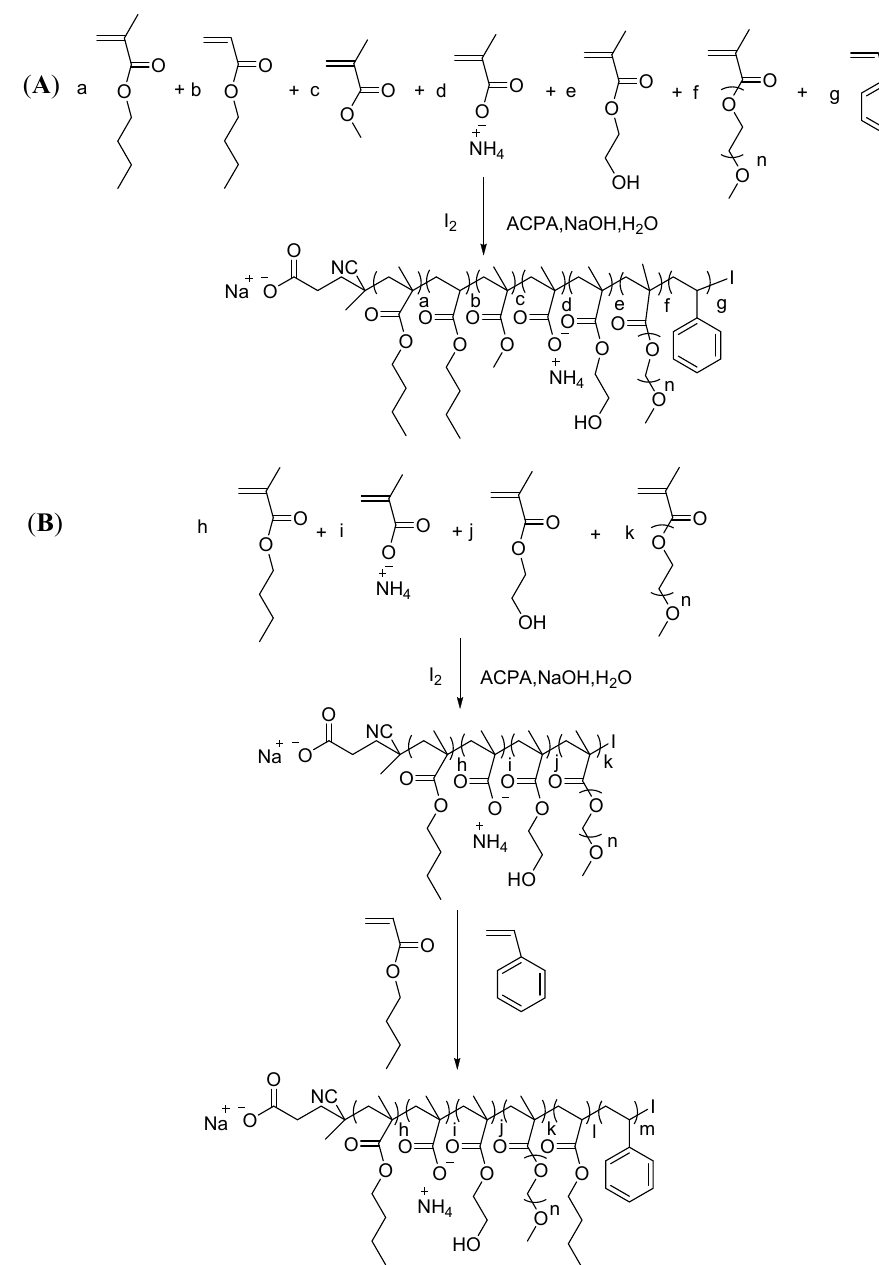
Figure 1. ( A ) Synthetic route of styrene–acrylic emulsion copolymer via RITP and ( B ) chain extension reaction via RITP.